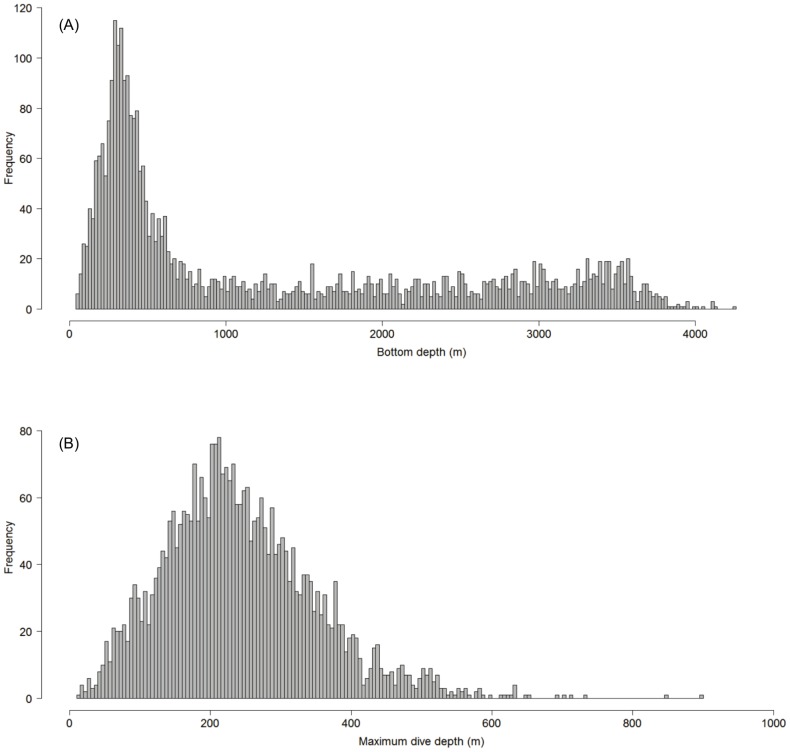
Frequency distributions.a) Frequency distribution of bottom depth across all seals (n  =  3,269) based on the number of dive locations obtained from the SRDL tags. b) Frequency distribution of maximum dive depth across all seals (n  =  3,269) based on number of dive locations obtained from the SRDL tags.